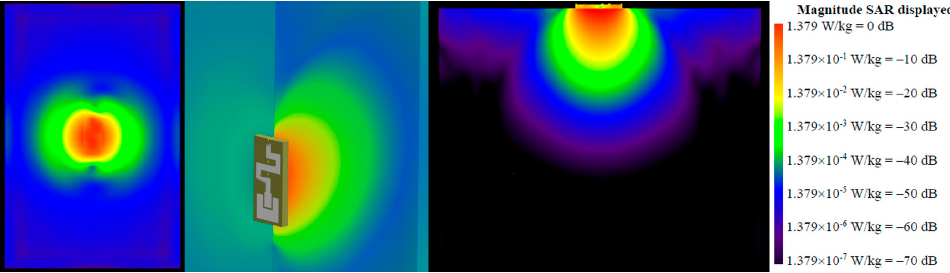
Figure 10. SAR distribution at 2.48 GHz.